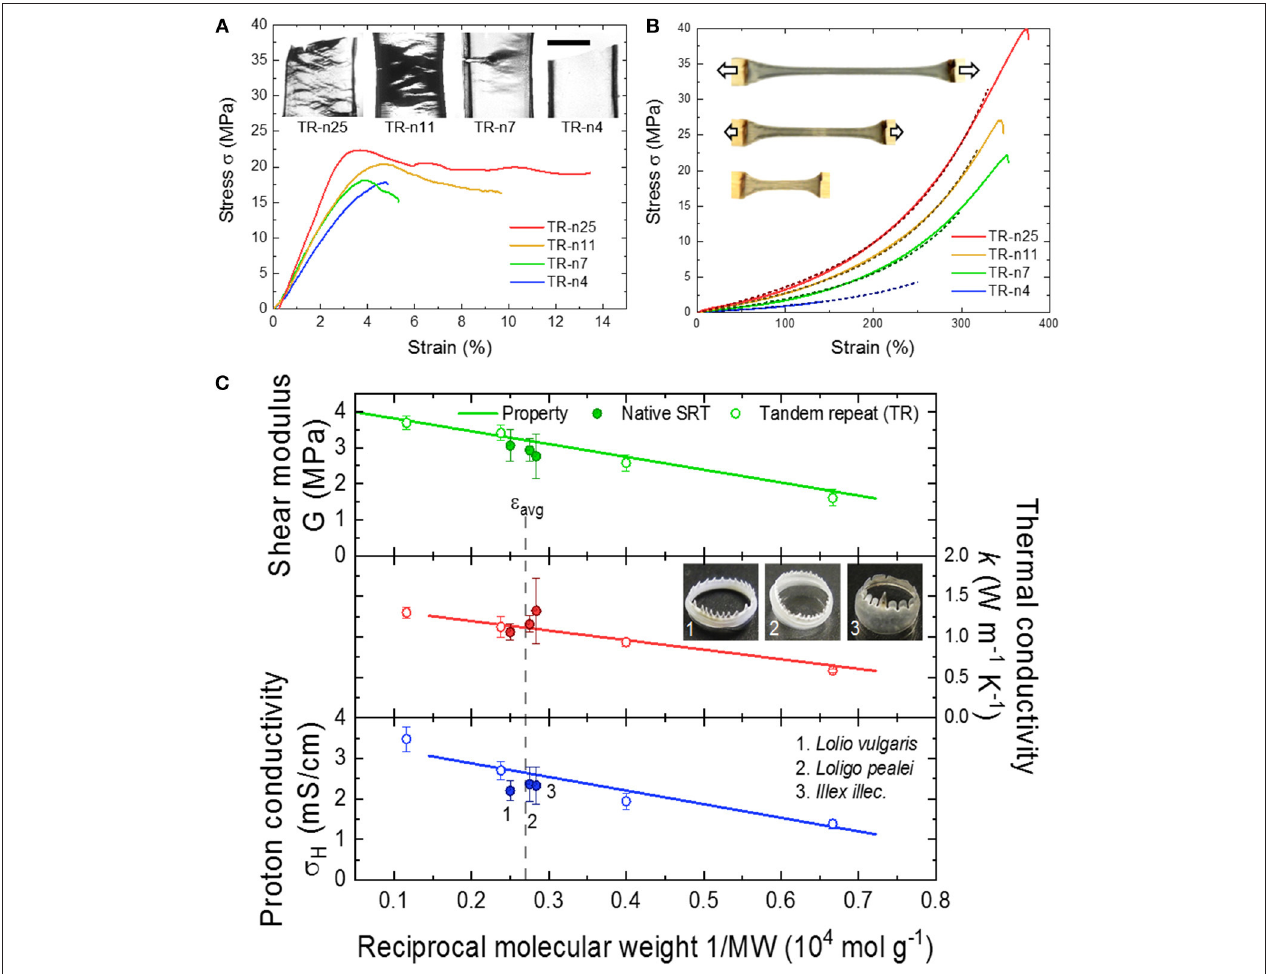
FIGURE 3 | Tunable properties of tandem repeat proteins inspired by SRT. Mechanical behavior in (A) dry and (B) wet conditions is highly dependent on tandem repetition. Reproduced with permission (Jung et al., 2016; Pena-Francesch et al., 2018c). Copyright 2016 National Academy of Sciences. Copyright 2018 American Chemical Society. (C) Mechanical and conducting (proton and thermal transport) properties of SRT-based materials are programmable and controlled by the amino acid composition, nanostructure, and network morphology. Reproduced with permission (Pena-Francesch et al., 2018b,c; Tomko et al., 2018). Copyright